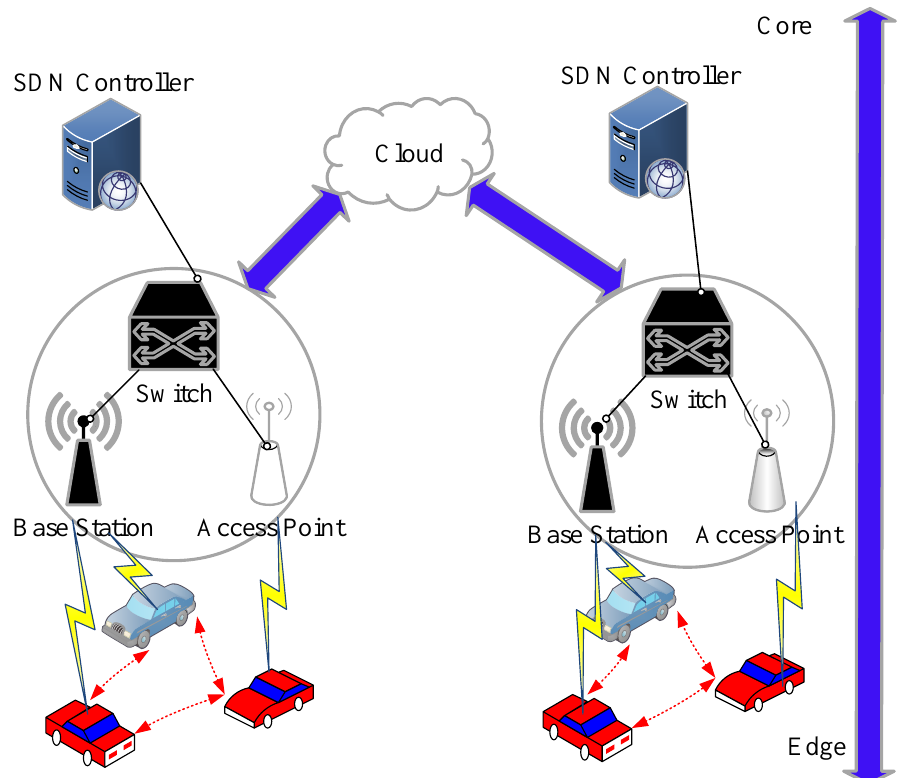
Figure 6. SDN Architecture of IoT based on Fog